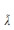
Global ACIs.A. Individual ACI estimated on 10,000 trials for all 16 participants. λ˜ and CVD are indicated below each image. B. Mean ACI for the participants collectively (estimated with λ = 1,191). C. Same ACI, with non-significant weights set to 0 (corrected t-test, FDR<0.01) and formant trajectories superimposed. In each ACI, weights are divided by their maximum absolute value.